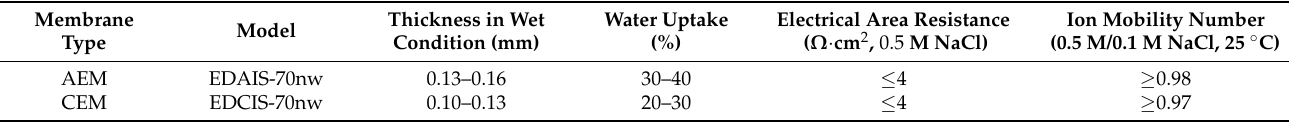
Table 1. Main performance parameters of ion exchange